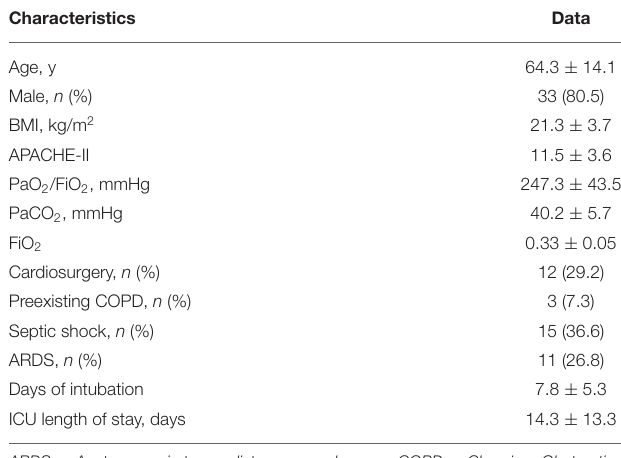
TABLE 1 | Main characteristics of the study